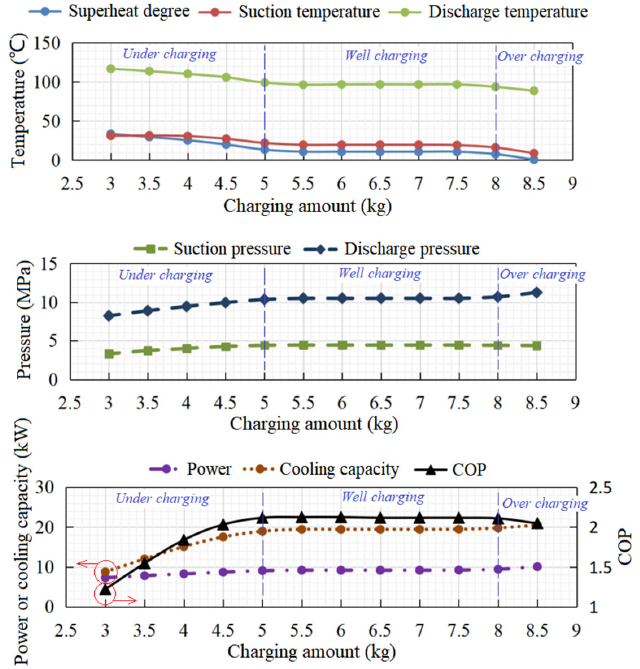
Figure 6. The global performance of the transcritical CO 2 system under various refrigerant charging amounts.